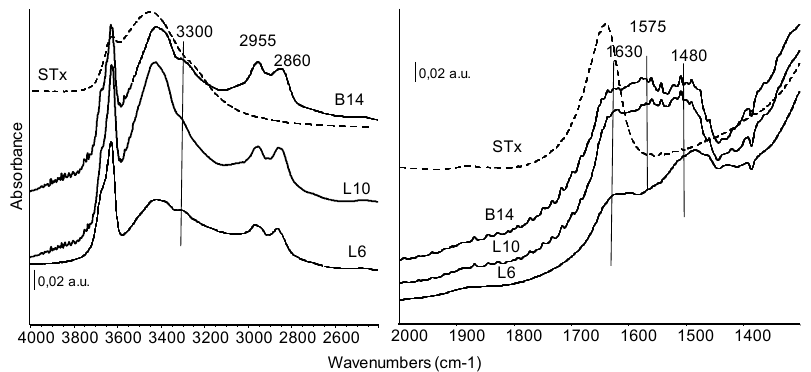
Figure 6. FT-IR skeletal spectra of all the organo-clays samples prepared at similar initial amines molarity. Dashed line: STx reference spectrum.